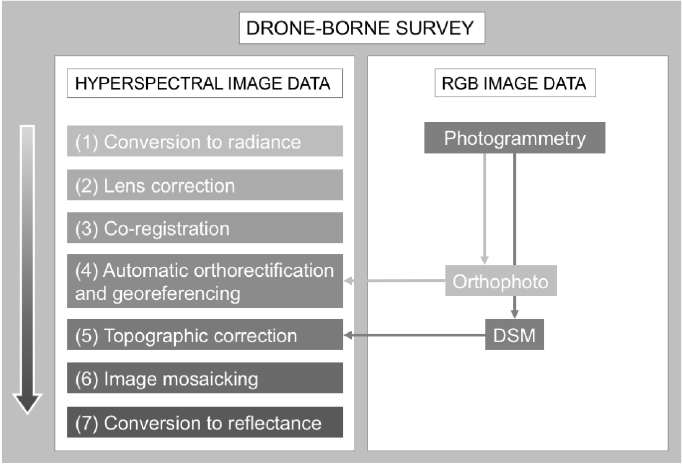
Figure 2. Flowchart of the processing